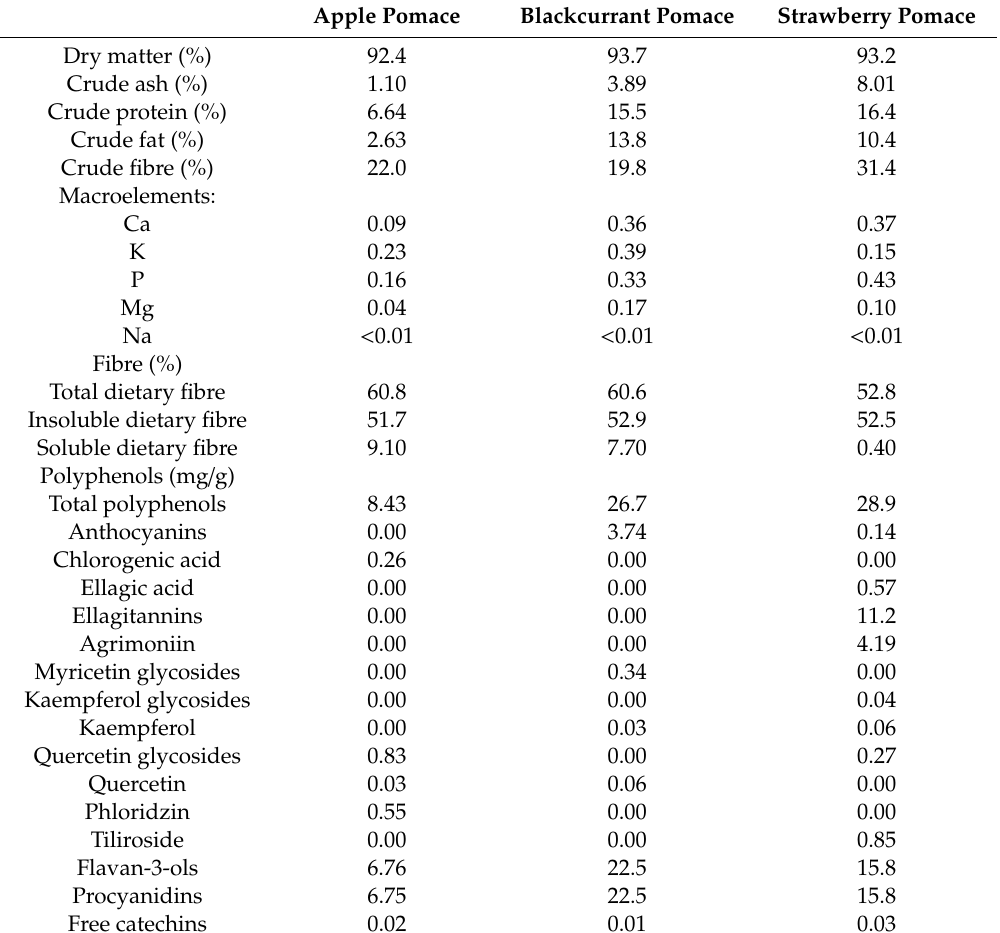
Table 2. Nutrient composition and polyphenols content of the fruit